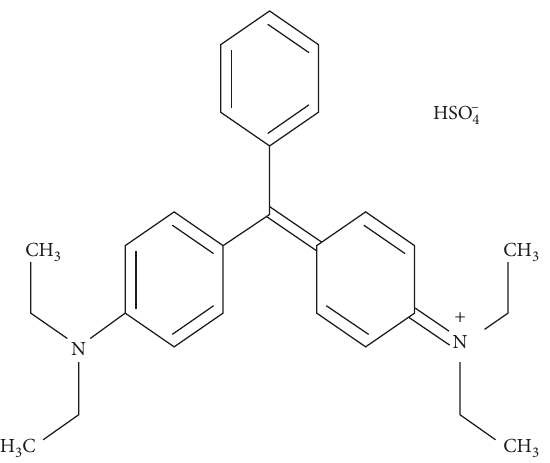
Figure 3: Chemical structure of Brilliant Green